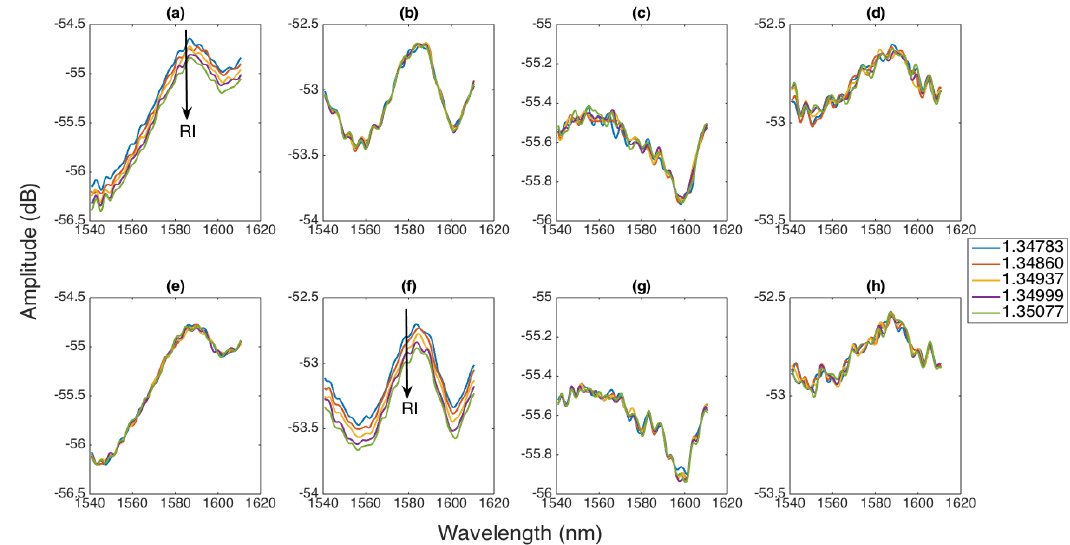
Figure 5. Evaluation of the multiplexing capability of the proposed approach. The chart proposes the spectra of each BR sensor on each column (left to right: BR1, BR2, BR3, and BR4) as the RI changes from 1.34783 to 1.35077. First row: spectra of ( a ) BR1, ( b ) BR2, ( c ) BR3, and ( d ) BR4 sensors when the BR1 sensor is exposed to a RI change, while the other three sensors are held at the reference RI. Second row: spectra of ( e ) BR1, ( f ) BR2, ( g ) BR3, and ( h ) BR4 sensors when the BR2 sensor is exposed to a RI change, while the other three sensors are held at the reference RI.